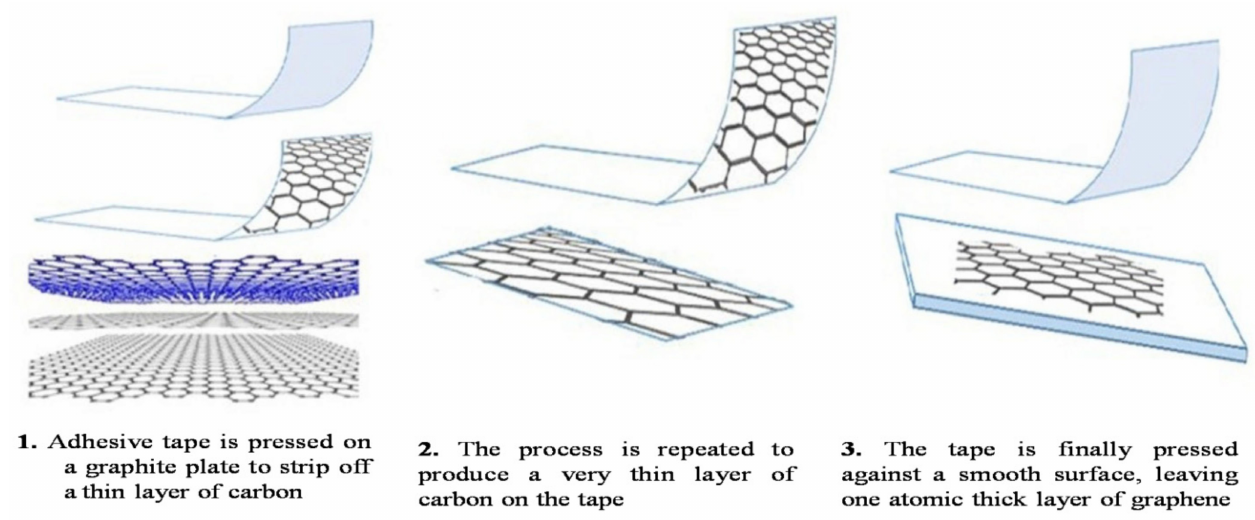
Figure 4. Mechanical exfoliation of graphene using the Scotch tape method [Reprinted with per- mission from ref. [39] Ibrahim, A.; Klopocinska, A.; Horvat, K.; Abdel Hamid, Z. Graphene-Based Nanocomposites: Synthesis, Mechanical Properties, and Characterizations. Polymers 2021 , 13 , 2869. https://doi.org/10.3390/polym13172869, Copyright ©